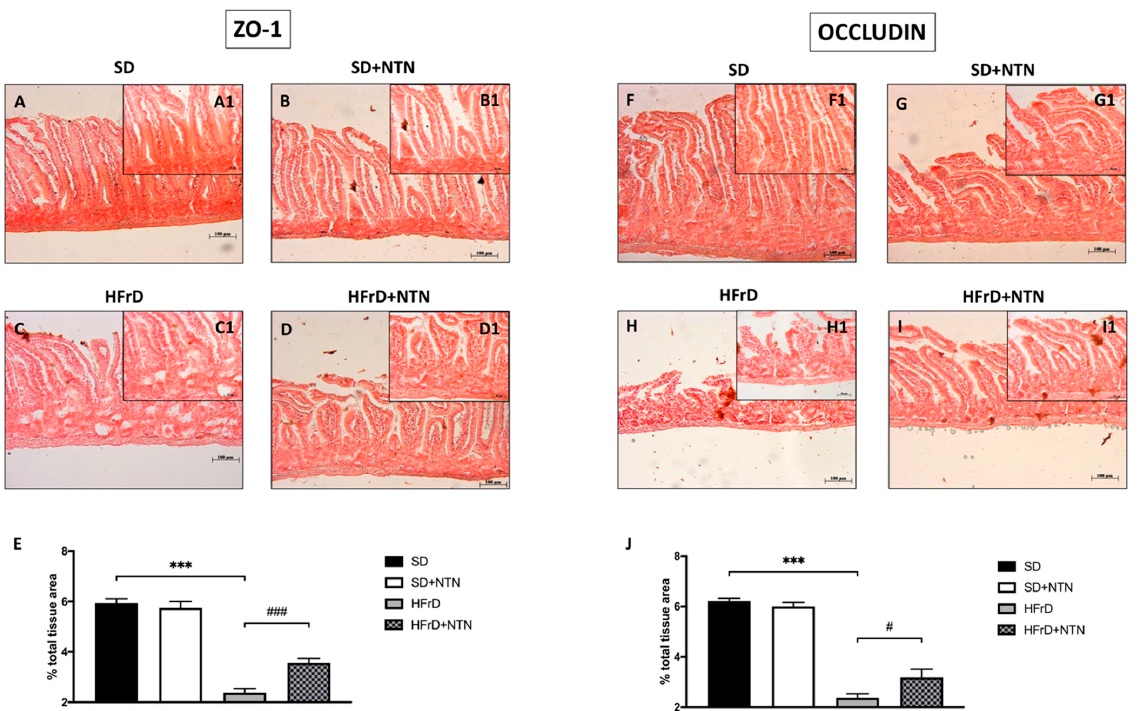
Figure 11. Effect of NTN on intestinal epithelial integrity in HFrD mice. Intestinal tissues of SD and SD + NTN mice displayed high expressions of ZO-1 ( A , B , E ) and Occludin ( F , G , J ) proteins, contrariwise TJs expressions were reduced after HFrD ( C , E , H , J ). NTN two-week treatment significantly restored ZO-1 ( D , E ) and Occludin ( I , J ) expressions. Data are representative of at least three independent experiments. Values are means ± SEM. One-Way ANOVA test. *** p < 0.001 vs. SD; # p < 0.05 vs. HFrD; ### p < 0.001 vs. HFrD.